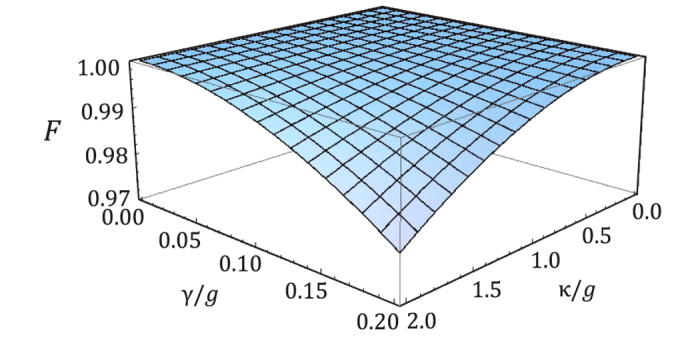
The fidelity (in amplitude) functions of γ/g and κ/g at gh = gv = g and ω = 0.